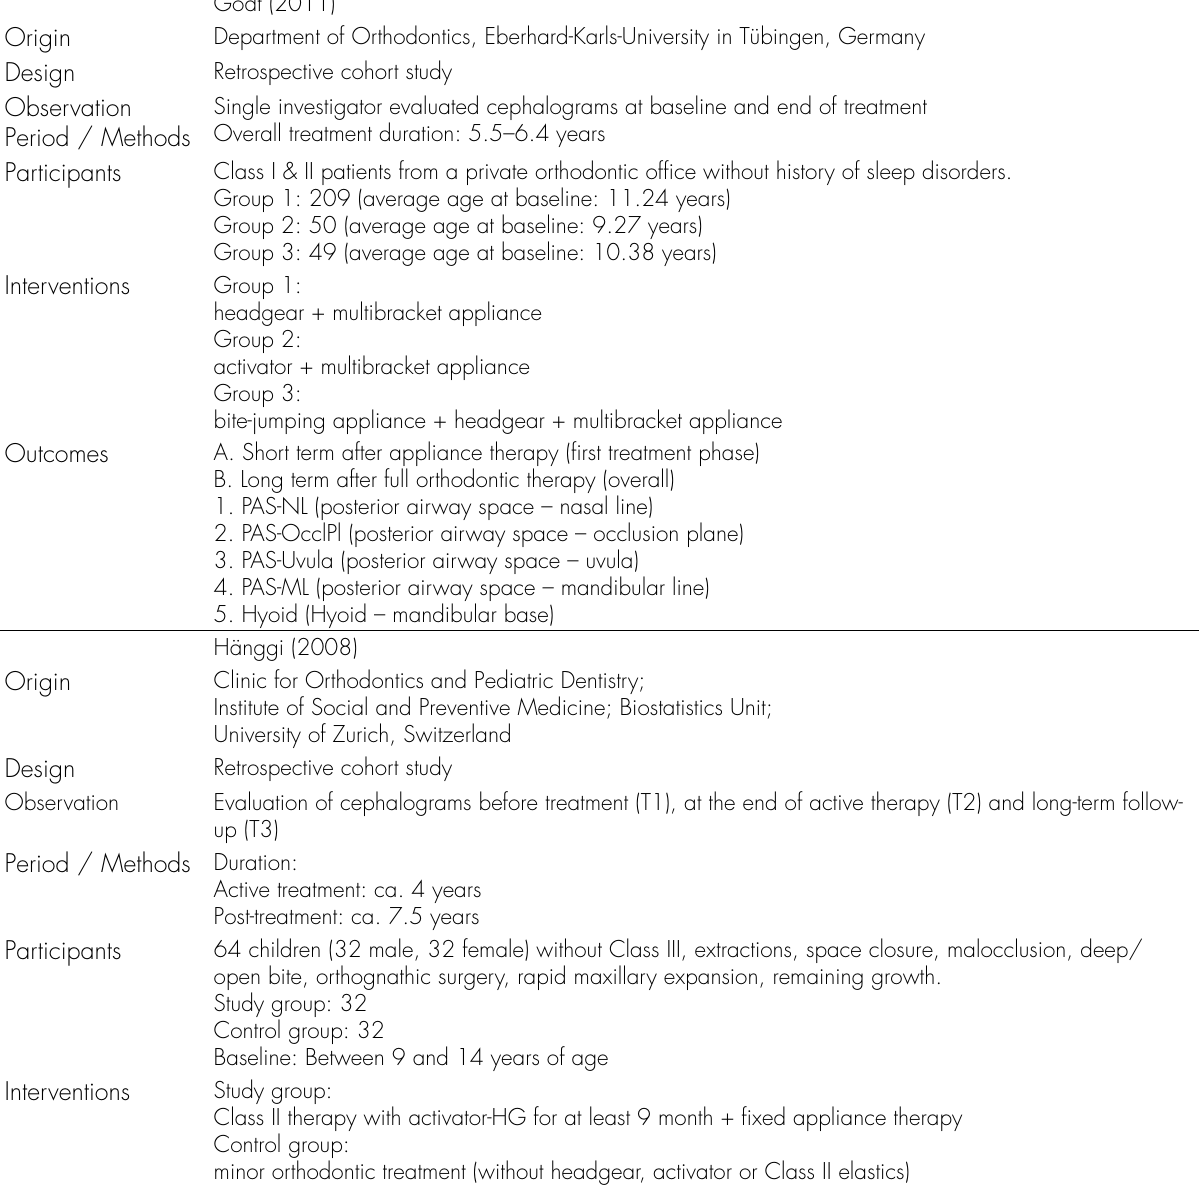
Table I. Characteristics of included